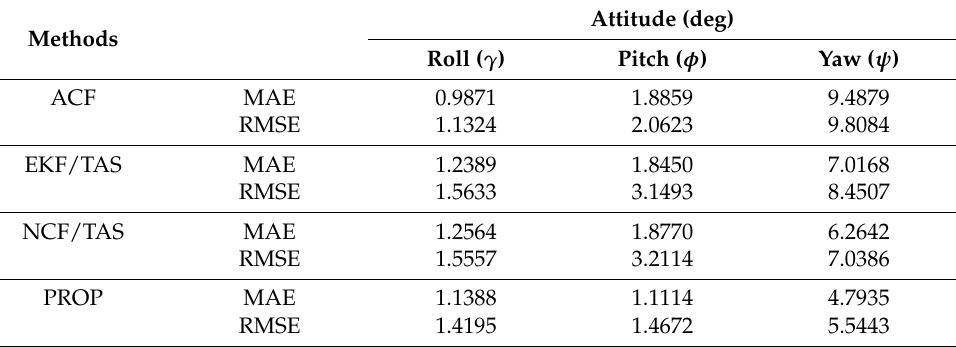
Figure 7. GPS/INS integrated navigation result is used as true values. Three-axis attitude error of other four algorithms in flight is shown for pitch, roll, and yaw error angle (from ( a – c ), respectively). Table 5. In the experiment, the attitude error evaluation indexes of MAE (Mean Absolute Error) and RMSE (Root Mean Square Error) calculated by the proposed fusion algorithm are compared with those calculated by the adaptive complementary filter (ACF), the two-vector extended Kalman filter fused with airspeed (EKF/TAS), and the nonlinear complementary filter fused with airspeed